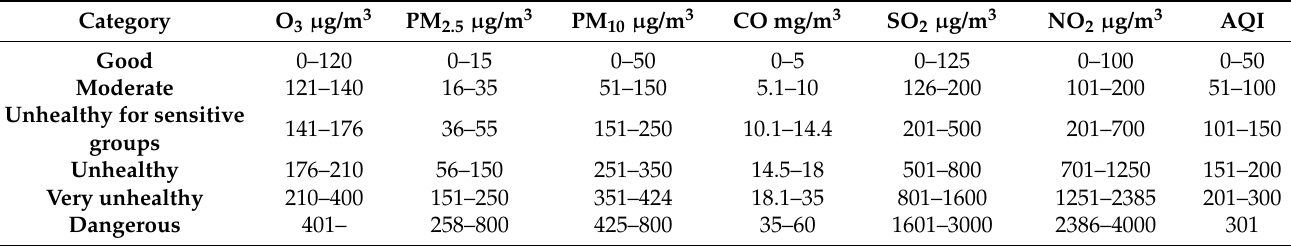
Table 2. Index levels depending on the concentration of each pollutant [28].